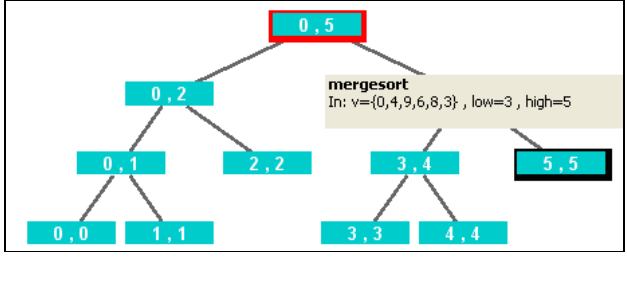
Figure 6. Semantic zoom on a node of the recursion tree for mergesort